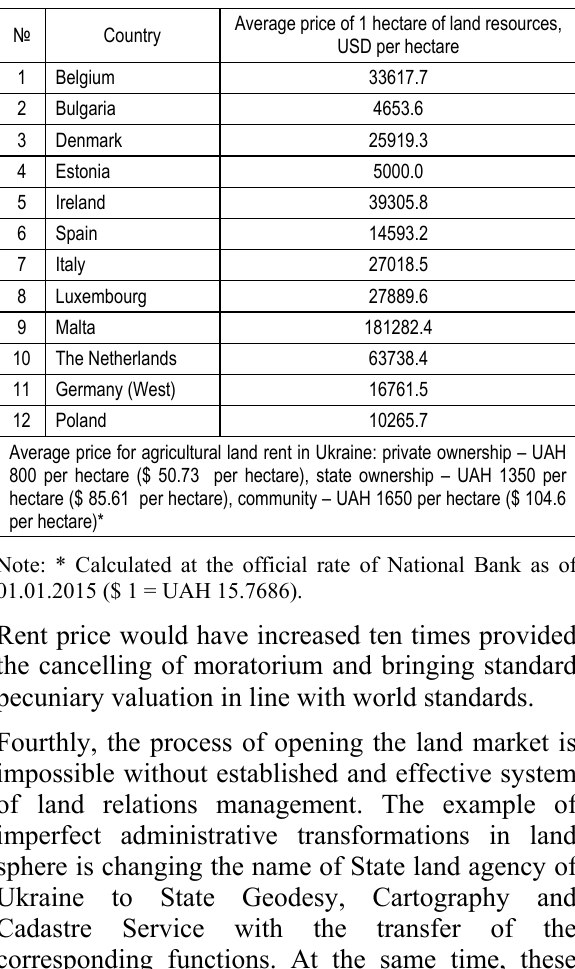
Table 3. The average price of 1 hectare of